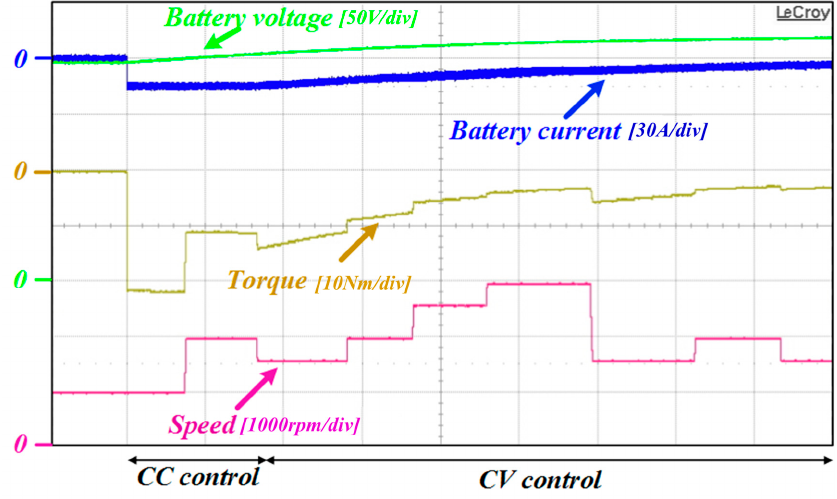
Figure 13. CC-CV control with sudden speed variation (charging current: 15 A, charging voltage: 250 V).